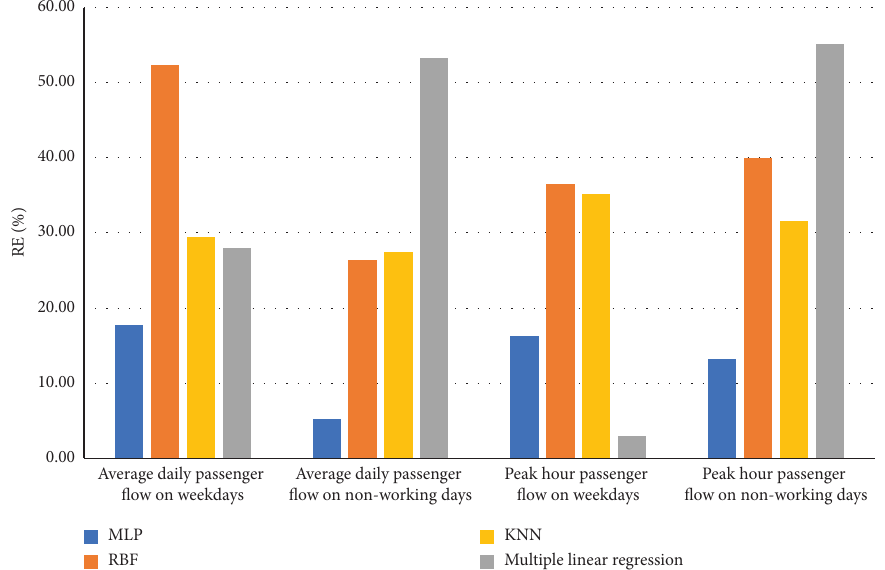
Figure 19: Comparison of predicted results of Wangfujing Station.